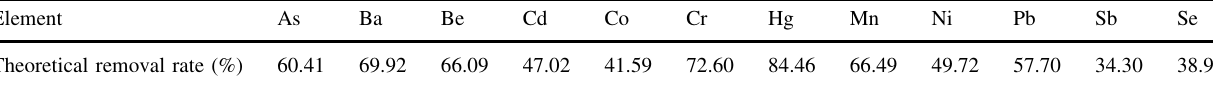
Table 9 Theoretical removability of trace elements in No.14 coal from Huolinhe mine (Recovery of clean coal was 58.38% at a separation density of 1.40 g/cm 3 ) Element As